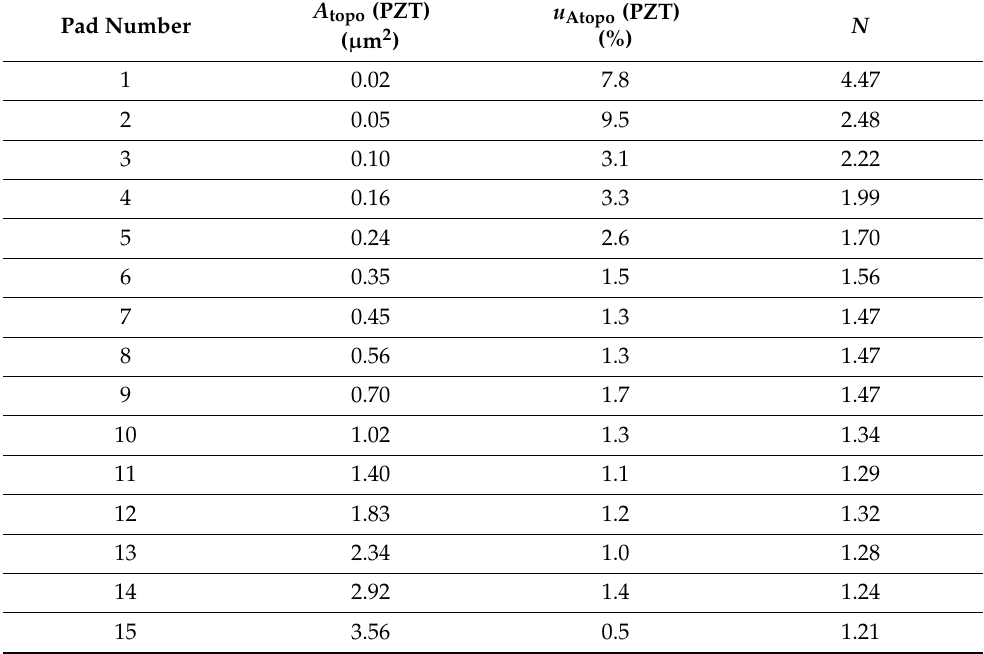
Figure 5. SEM images of a pattern formed by 15 gold pads ( a ). Different zones of this pattern are imaged: Top right in ( b ), middle left in ( d ) and bottom right in ( e ); ( c , f ) high resolution images of individual pads. All scale bars correspond to 400 nm. Table 1. Measured areas A topo (PZT) and corresponding uncertainties u Atopo (PZT) for the 15 gold pads on the PZT sample, the correction factor N used to correct area values measured on the PMN-PT sample.